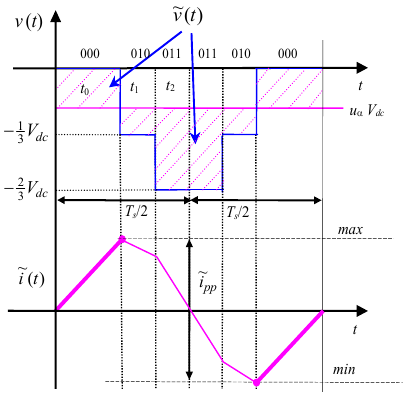
Figure 7. Output voltage and current ripple for DPWM − technique in one switching period (sector III, − 1/3 ≤ u α ≤ 0).